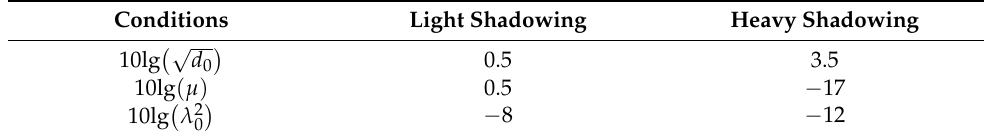
Table 1. Parameters of Loo model. Conditions Light Shadowing Heavy